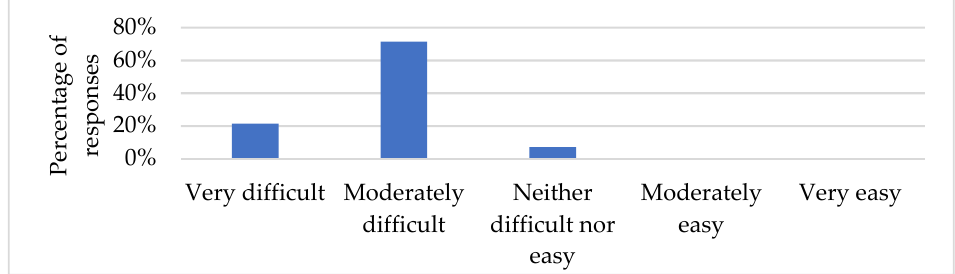
Figure 2. Difficulty to develop integrated land-use plans in Paraguay from the expert ′ s perspective.